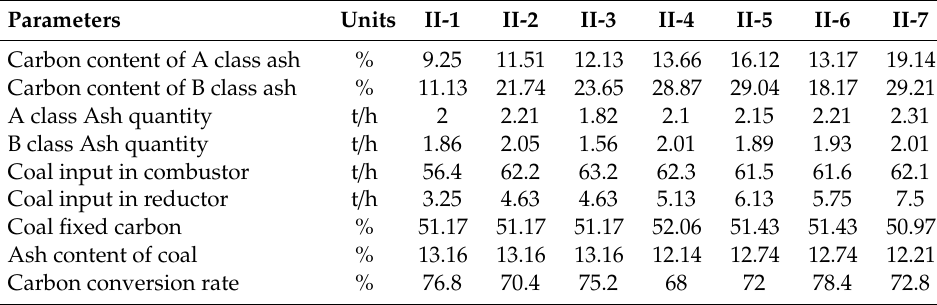
Table 7. The carbon conversion rate of coal input in the